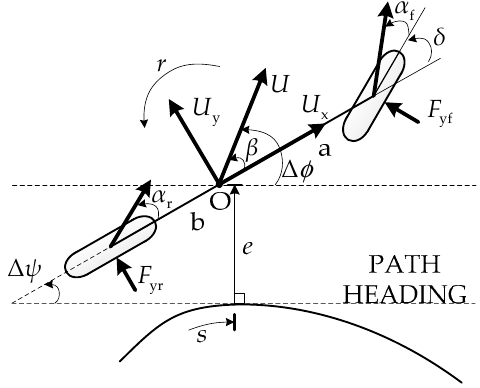
U are vehicle speed and the y